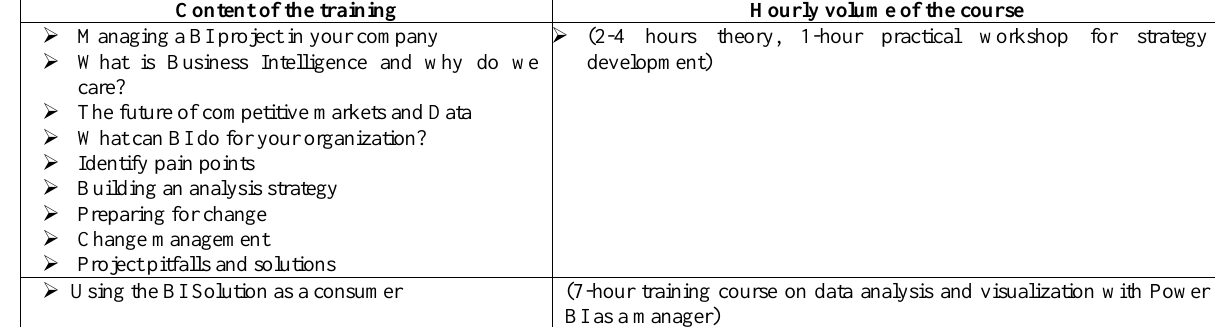
Table 1. Details and Content of BI Training for Managers and